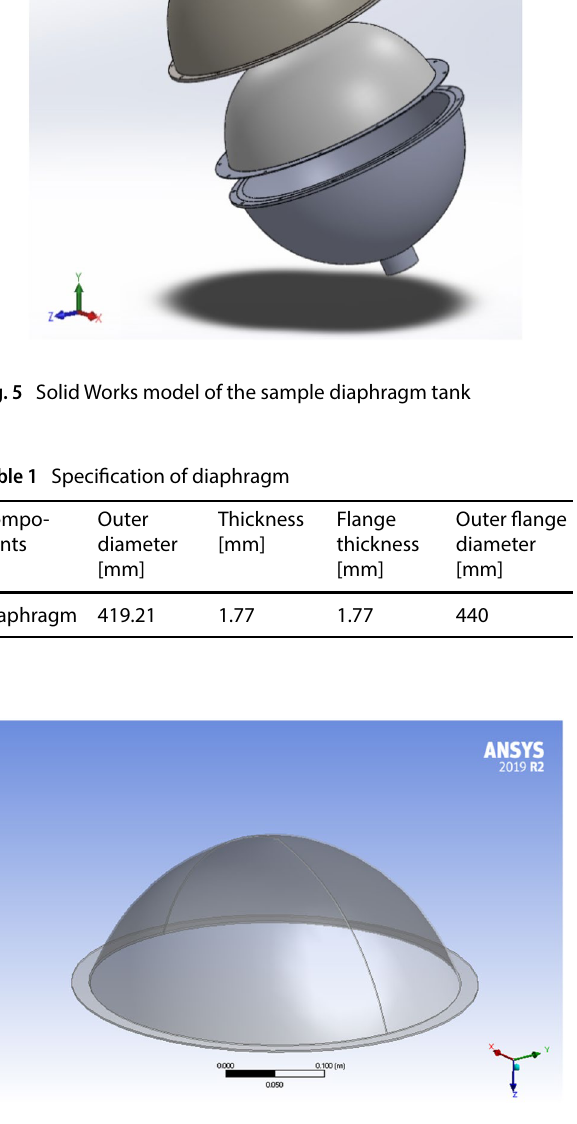
Fig. 6 Geometric model images of elastomer